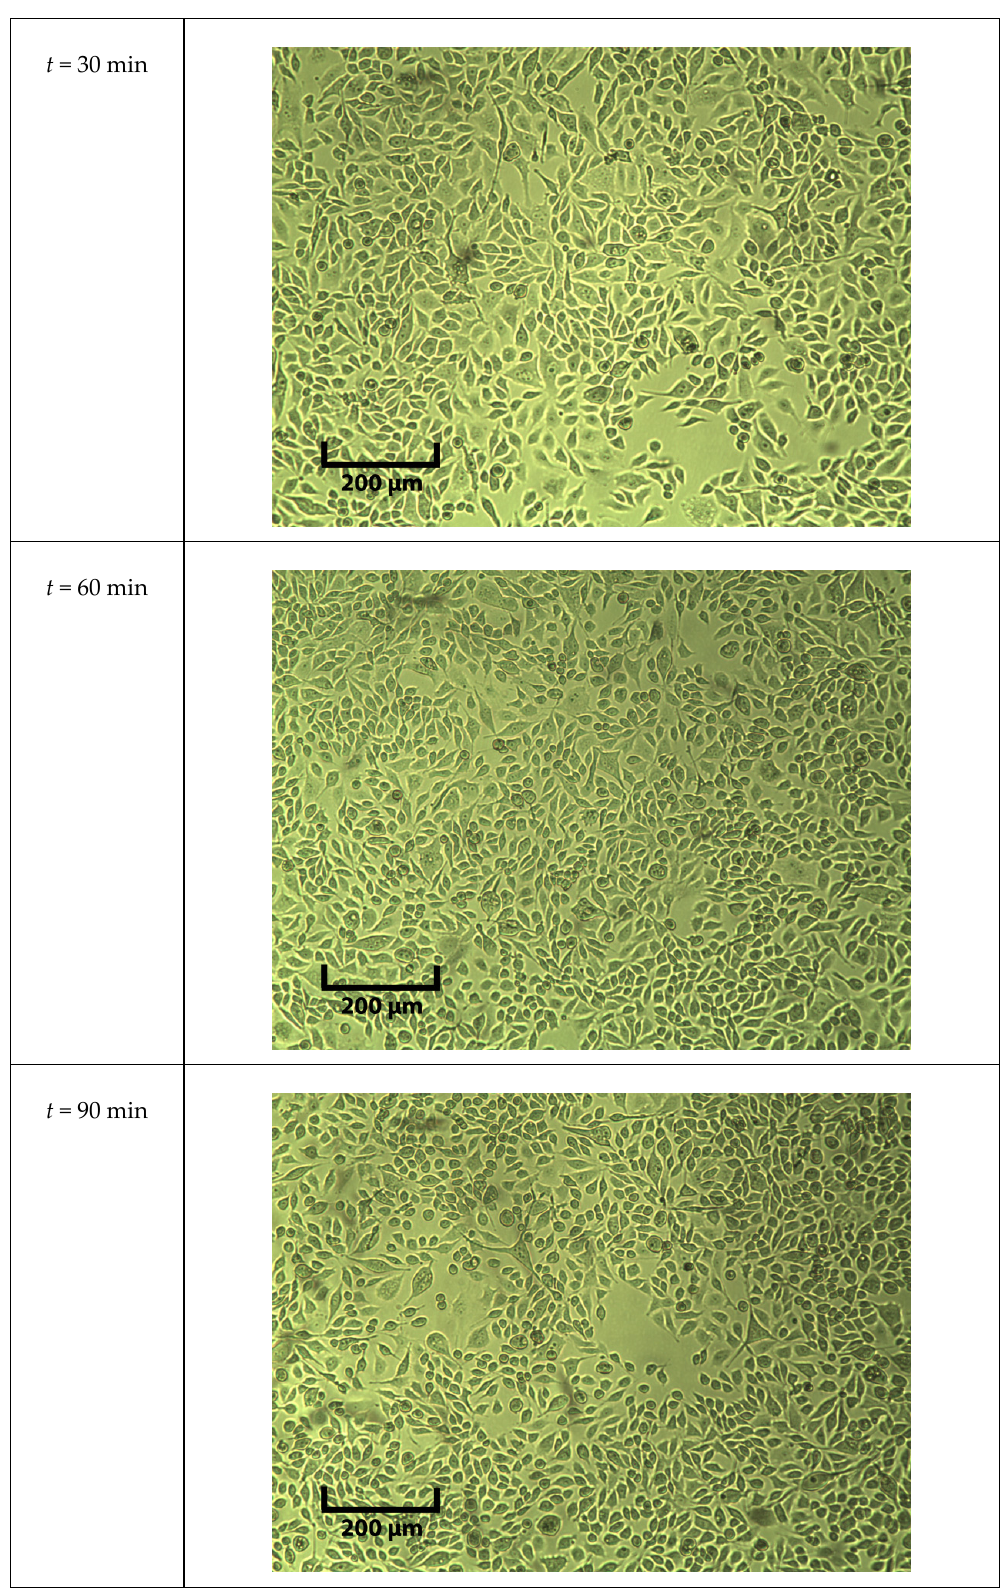
Figure A5. Pictures of cells exposed to room temperature DPBS under 5x objective at different time points.